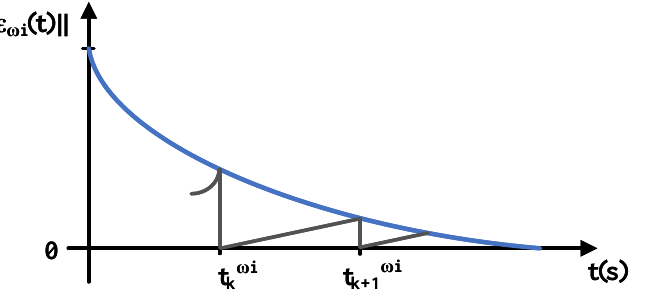
Figure 10. Event-triggered time generation